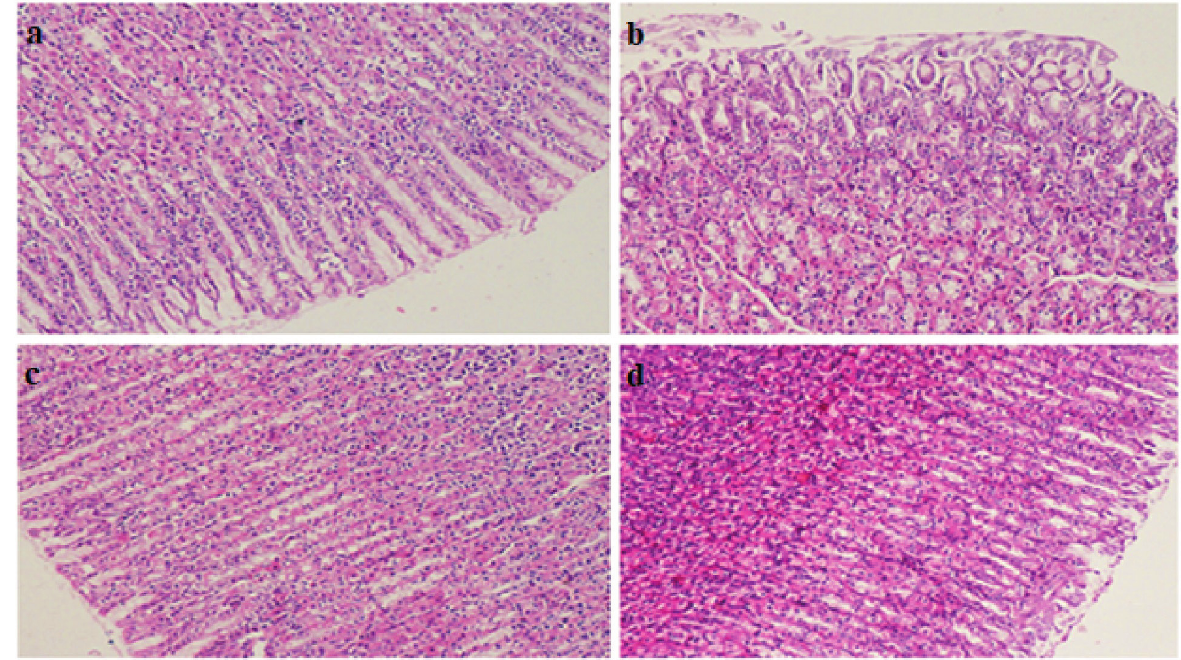
Figure 1 - Negative control ( a ), histopathological damage of gastric tissues from Positive control group ( b ), Standard drug control group ( c ) and Extract treated group of rats ( d ). Sloughed off superfi cial layer, infl ammatory cells infi ltration, gastric glands necrosis can be seen ( b ). Mild erosion of superfi cial epithelium with denuded epithelial cells, mild hemorrhages in lamina propria, very few infl ammatory cells were detected in standard control group of rats ( c ). Most of epithelial cells were normal but few denuded simple columnar epithelial cells were detected in superfi cial surface of mucosa, gastric glands near basement membrane of mucosa were normal, blood vessels in submucosa were congested ( d ).